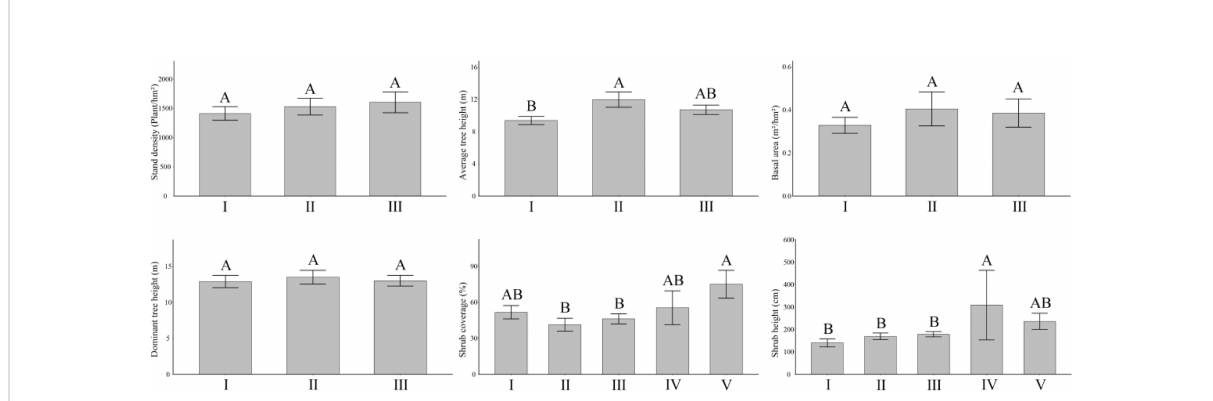
FIGURE 1 Distribution difference of aboveground vegetation in different forest land types. Above the error line, different capital letters indicate that there are signi fi cant differences among different forest land types. I, broad-leaved forest; II, coniferous forest; III, mixed coniferous and broad-leaved forest; IV, bamboo forest; V, shrub forest. The same